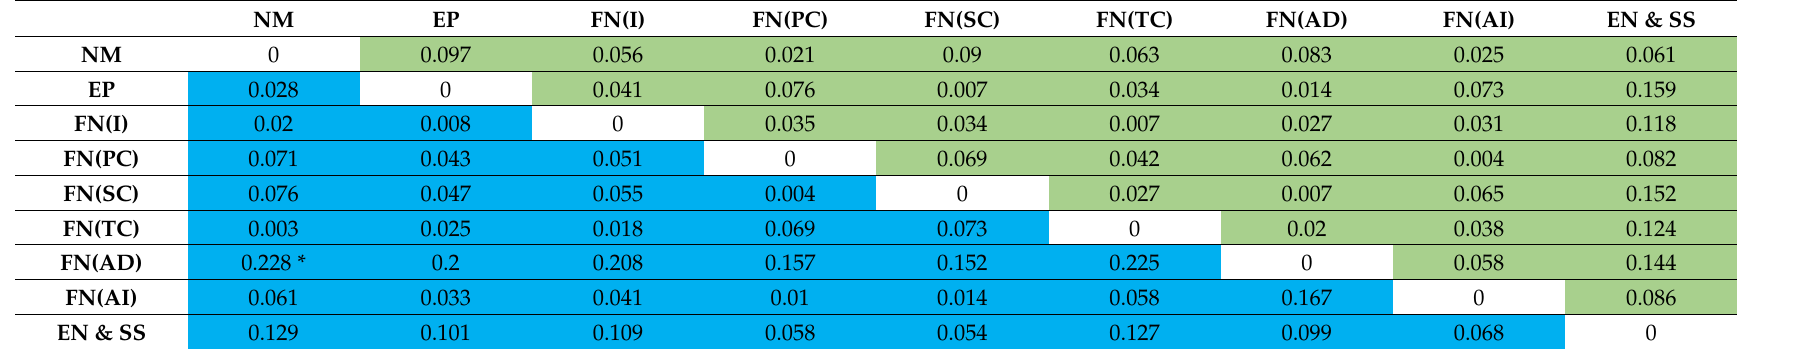
E. DEL-BI relationship is indicated in Blue colour; PHYSICAL-BI relationship is indicated in orange colour